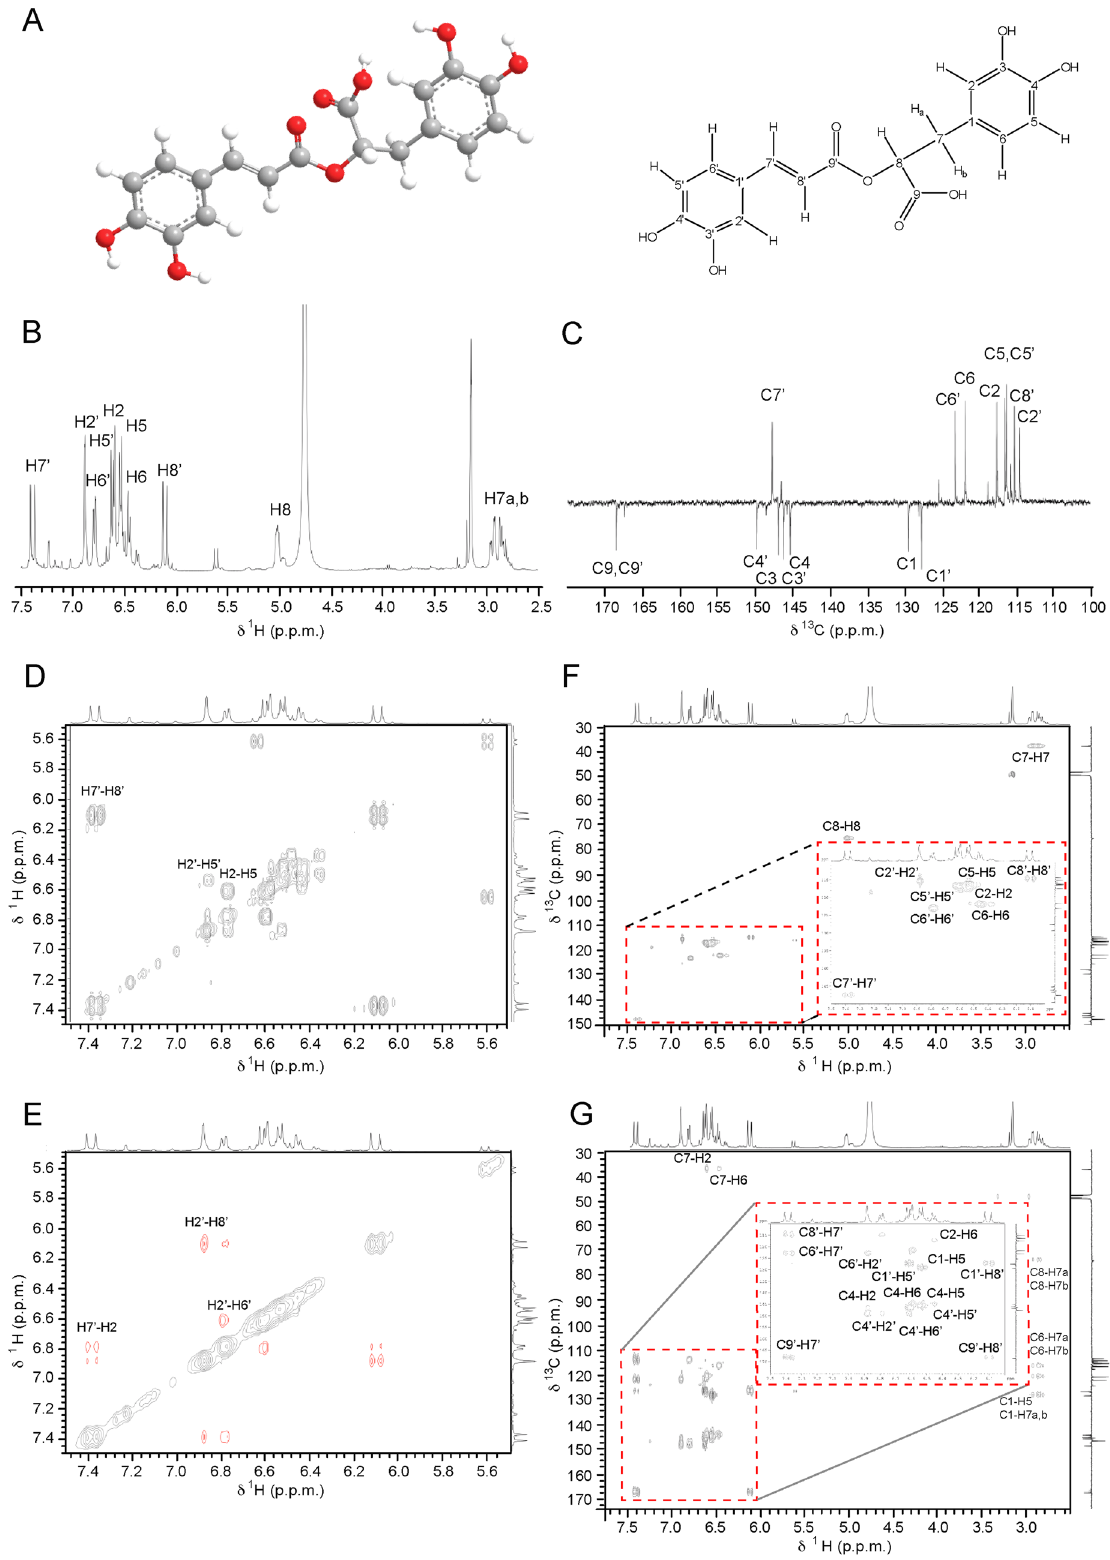
Figure 1. Structure elucidation of rosmarinic acid (RA) by 2D NMR spectroscopy. ( A ) Structure of RA. ( B ) 1D 1 H NMR and ( C ) 1D 13 C NMR spectra of RA. ( D ) 2D 1 H- 1 H COSY and ( E ) 2D 1 H- 1 H NOESY spectra of